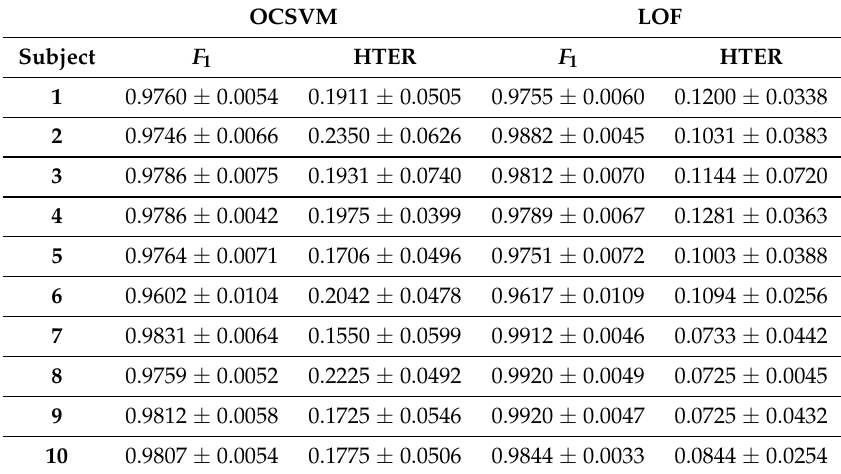
Table 1. Authentication test results of 10 subjects (Pattern